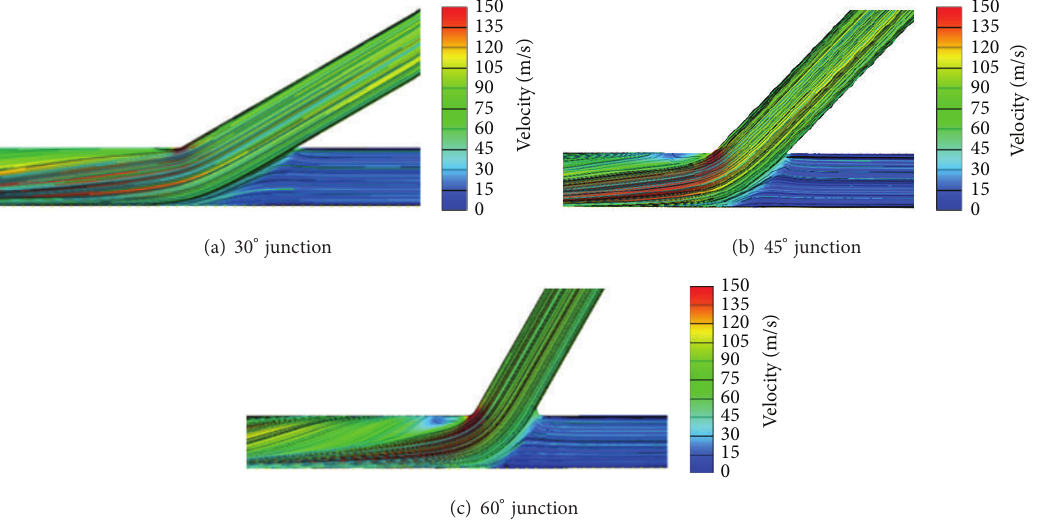
Figure 16: Velocity flow fields of junction with different lateral branch angles at 𝑄 13 = 0.9 , and 𝑀 3 = 0.34